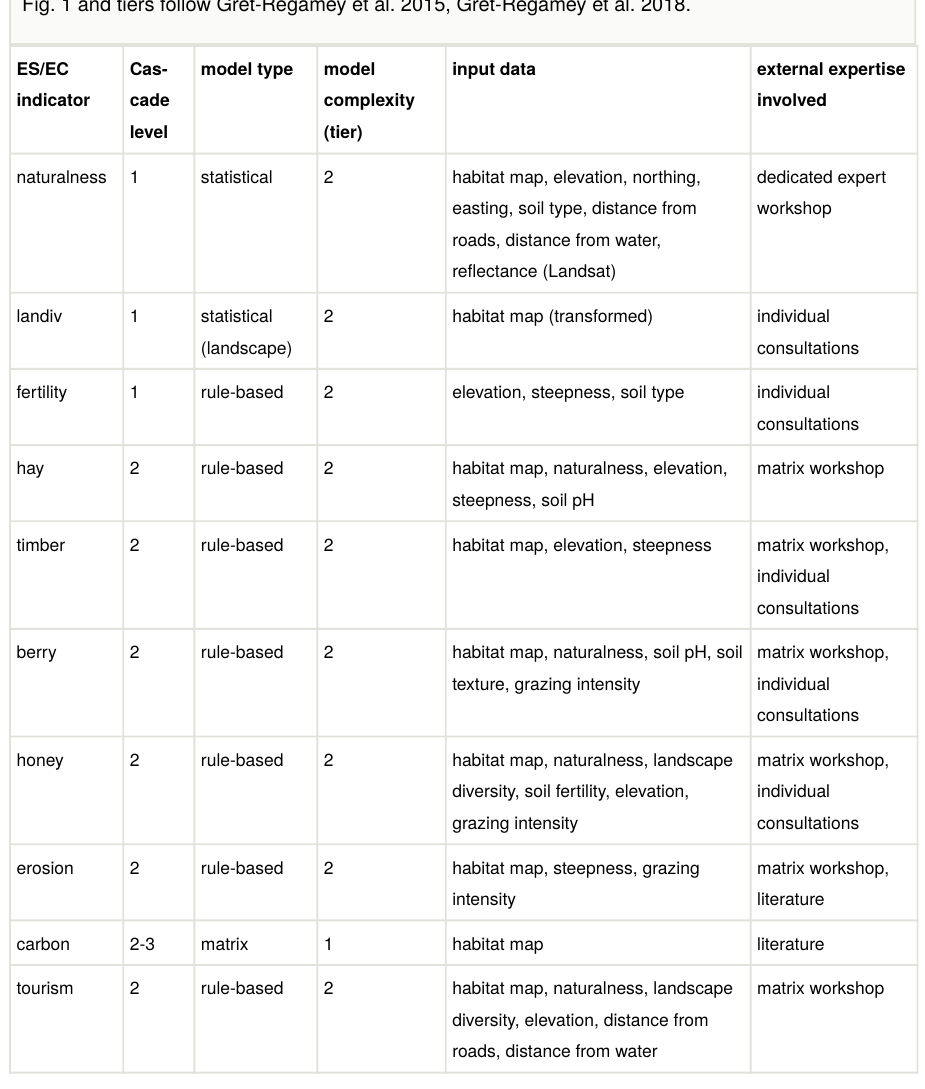
based models to the SAB for veri fi cation. Recommendations received from the SAB members were then built into the model rules. The details of the fi nal models are shown in Table 5 in the Results section. All models were implemented in R with add-on packages sp (Pebesma and Bivand 2005), rgdal (Bivand et al. 2016) and raster (Hijmans 2016). Table 5. Overview of the ecosystem condition (EC) and ES capacity models used. Cascade levels follow Fig. 1 and tiers follow Grêt-Regamey et al. 2015, Grêt-Regamey et al.